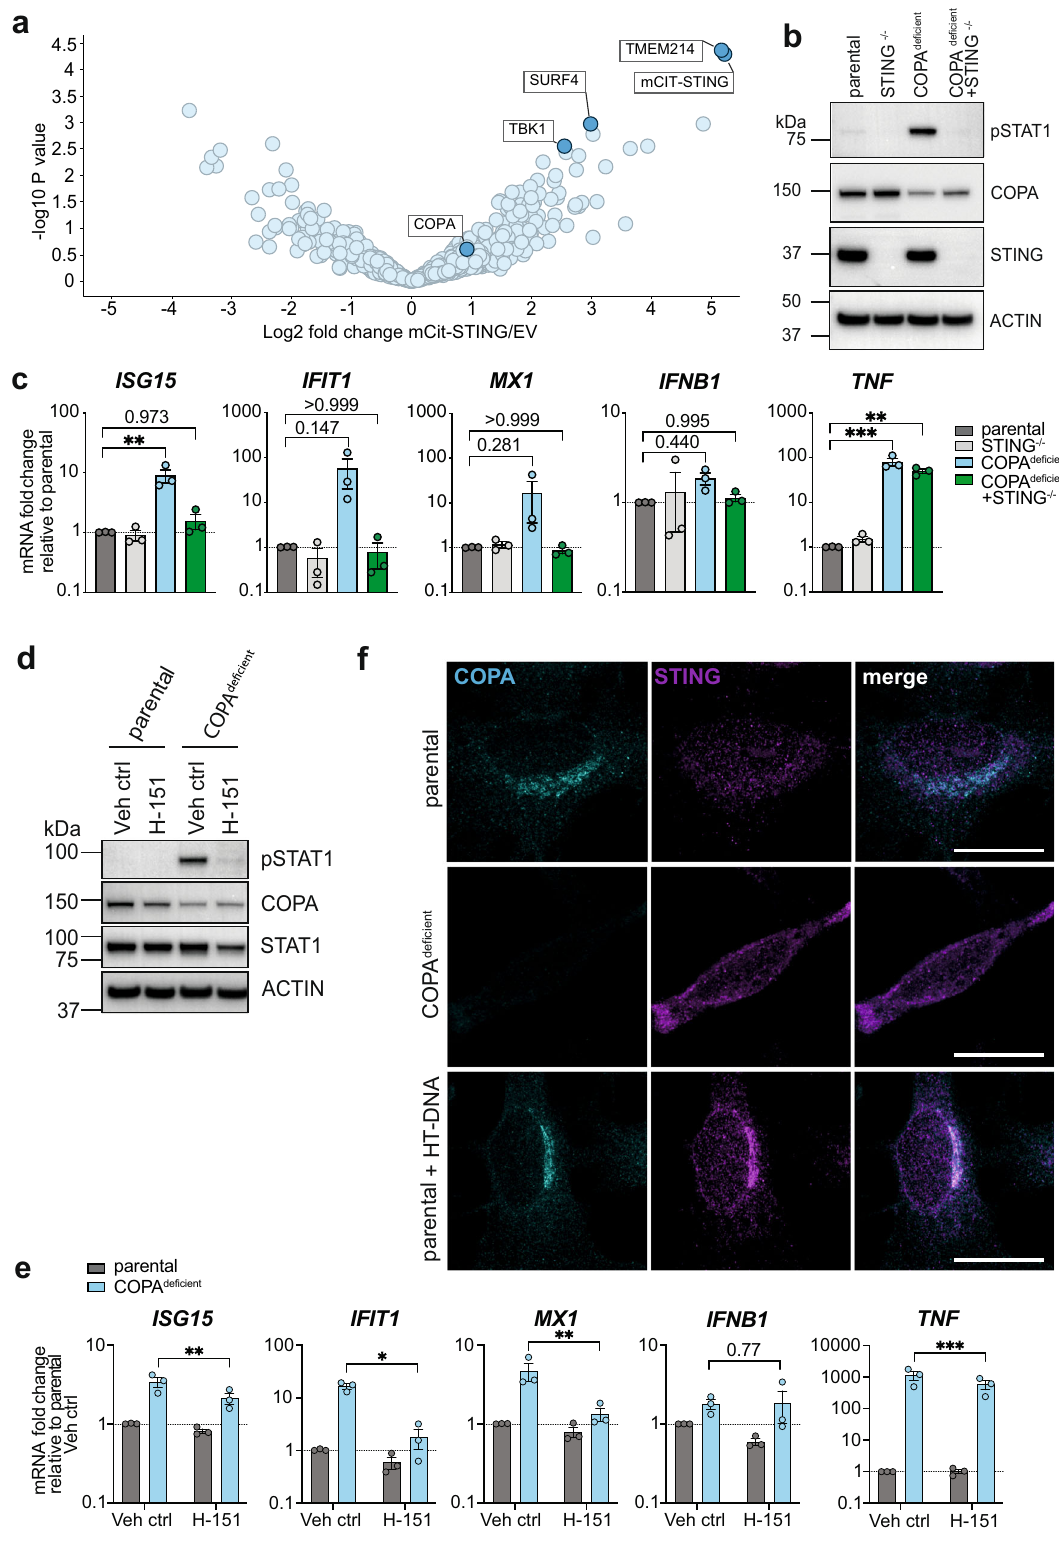
(Supplementary Fig. 3). Furthermore, in the context of potential pharmaceutical intervention, treatment of COPA de fi cient THP-1 cells with small-molecule STING inhibitor H-151 was able to markedly reduce baseline STAT1 phosphorylation (Fig. 2d) and type I IFN-mediated gene transcription (Fig. 2e), thus indicating a possible targeted treatment for COPA syndrome patients. NATURE COMMUNICATIONS| (2022) 13:2321